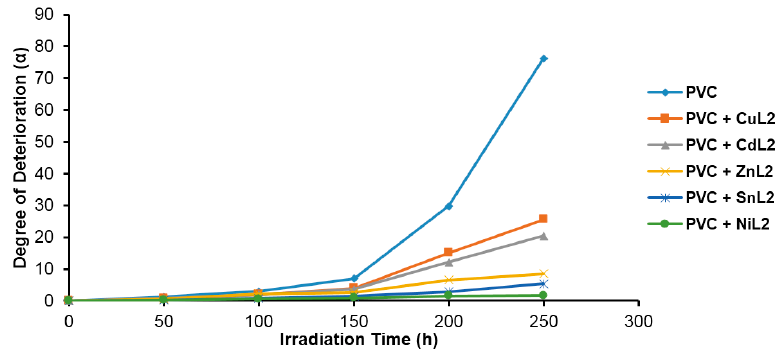
Figure 9. Effect of irradiation time (250 h) on α for PVC films (40 μ m thickness) containing ML 2 (0.5 wt %).